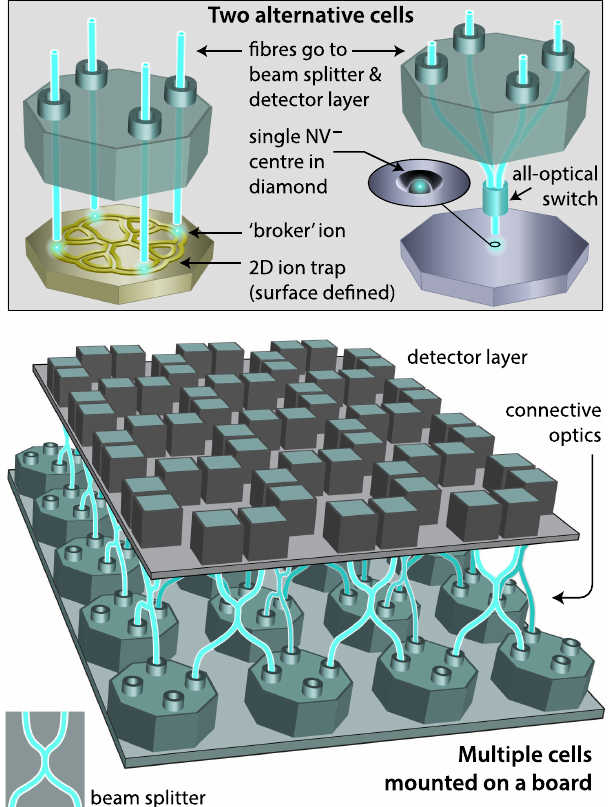
FIG. 6. Illustration of the cellular architecture in 3D. See